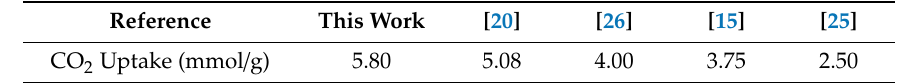
Table 3. Comparison results of CO 2 adsorption uptake of Ni-MOF-74 at 1 bar and 25 ◦ C with literature